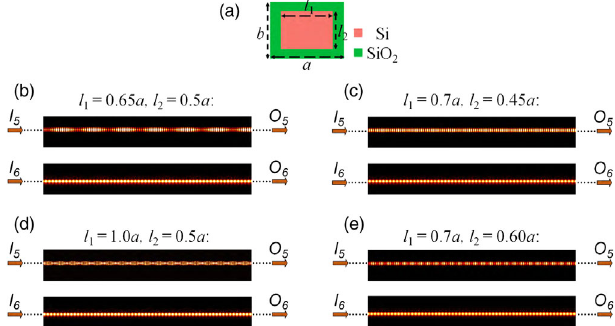
FIG. 12. The fabrication tolerance of the waveguide structure in Fig. 6. (a) The unit cell of PC channel with two variables l 1 and l 2 . (b) – (e) The simulated intensity patterns in the region near the output ports ( 940 – 980 μ m) with the sizes of silicon rods l ¼ 0 . 65 a , l ¼ 0 . 5 a (b), l ¼ 0 . 7 a , l ¼ 0 . 45 a (c), l ¼ 1 . 0 a , 1 2 1 2 1 l ¼ 0 . 5 a (d), and l ¼ 0 . 7 a , l ¼ 0 . 60 a (e). The propagation 2 1 2 length of PC ( I 5 - O 5 ) and silica channels ( I 6 - O 6 ) is 1000 μ m ( 2703 a ) and the working wavelength is 1550 nm. The width of the PC (silica) channel is 832.5 nm (600 nm).